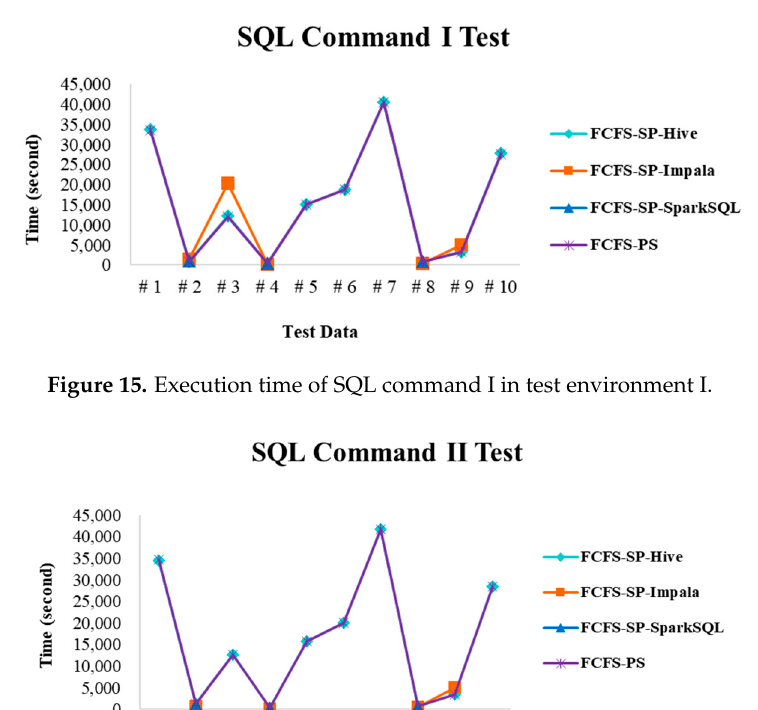
Figure 16. Execution time of SQL command II in test environment I.